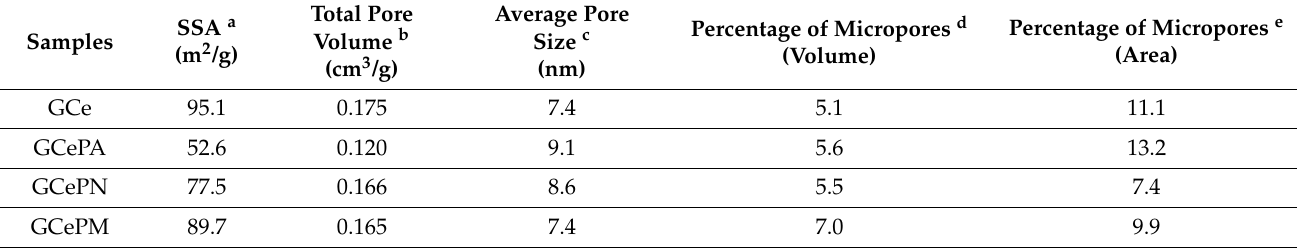
Table 3. Textural properties of the monoliths with different